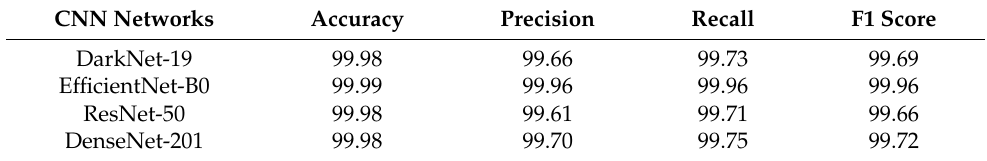
Table 2. Performance evaluation metrics of the proposed method compared among four CNN